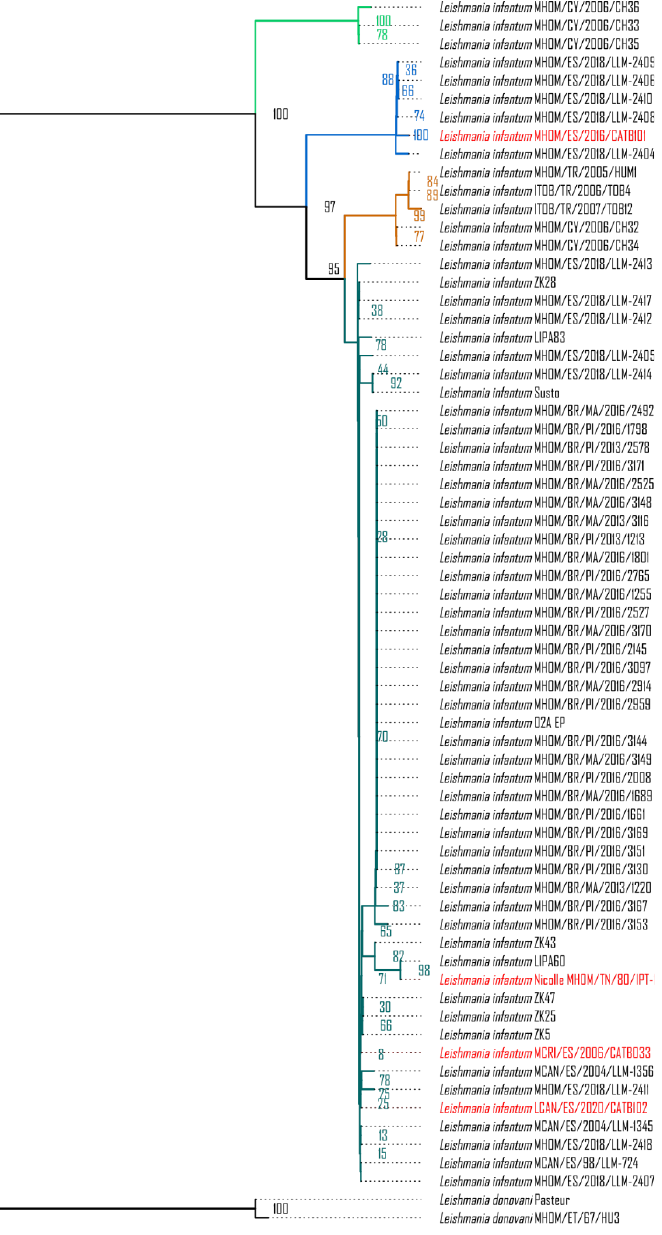
Figure 1. Maximum likelihood phylogenetic tree of the L. donovani – L. infantum group . L. donovani – L. infantum consensus phylogeny was constructed using the conserved region of the maxicircle, concatenating the coding sequences of 12S rRNA, 9S rRNA, ND8, ND9, MURF5, ND7, CO3, CYb, ATPase 6, ND2, G3, ND1, CO2, MURF2, CO1, G4, ND4, G5 (ND3), RPS12, and ND5. The maximum likelihood tree (log-likelihood −2 1183.118) was modeled with the Tamura – Nei 1993 model with 1000 bootstraps. Taxa highlighted in red correspond to the novel maxicircle sequences of MHOM/TN/80/IPT-1, MHOM/ES/2016/CATB101, MCRI/ES/2006/CATB033, and LCAN/ES/2020/CATB102 samples. Subspecies phylogenetic clusters, types, or groups are highlighted in green, blue, yellow, and turquoise, corresponding to the same clusters identified in Solana et al., 2022 [12].